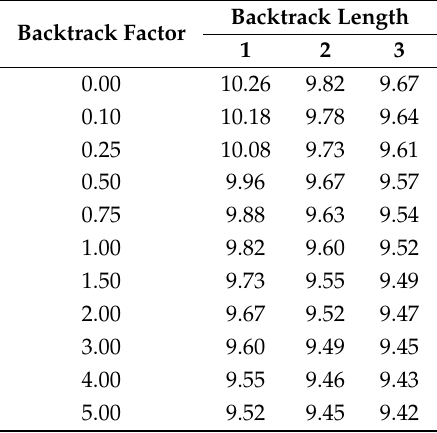
Table 3. 16:1 Estimate Ratios by Backtrack